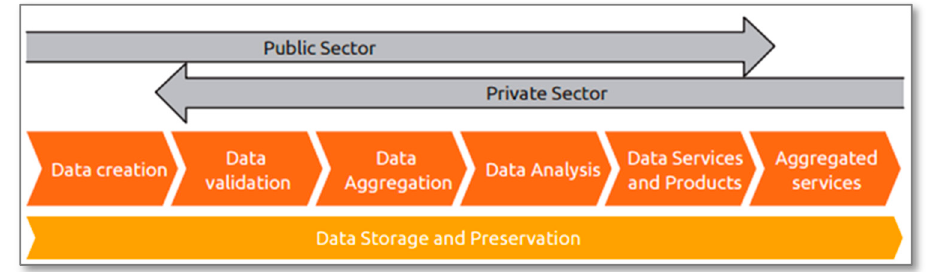
Figure 4. Open data value chain. Reproduced from reference [13], with permission from the European Union, 2015.